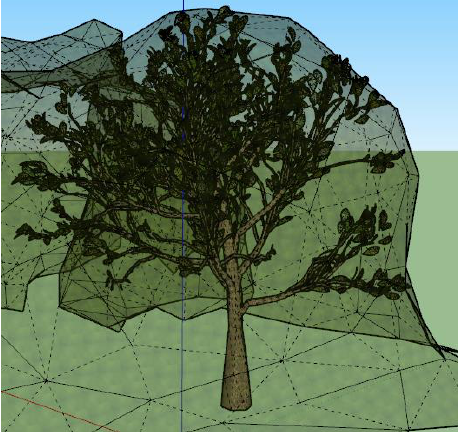
Figure 9. First alteration of the tree template Lastly, additional branches and leaves were added to achieve a mangrove tree model that fits into the tree crown model. Figure 10 shows the final 3D mangrove tree model. This model conforms better to the tree crown described by the DSM, compared to the default template shown in Figure 7.